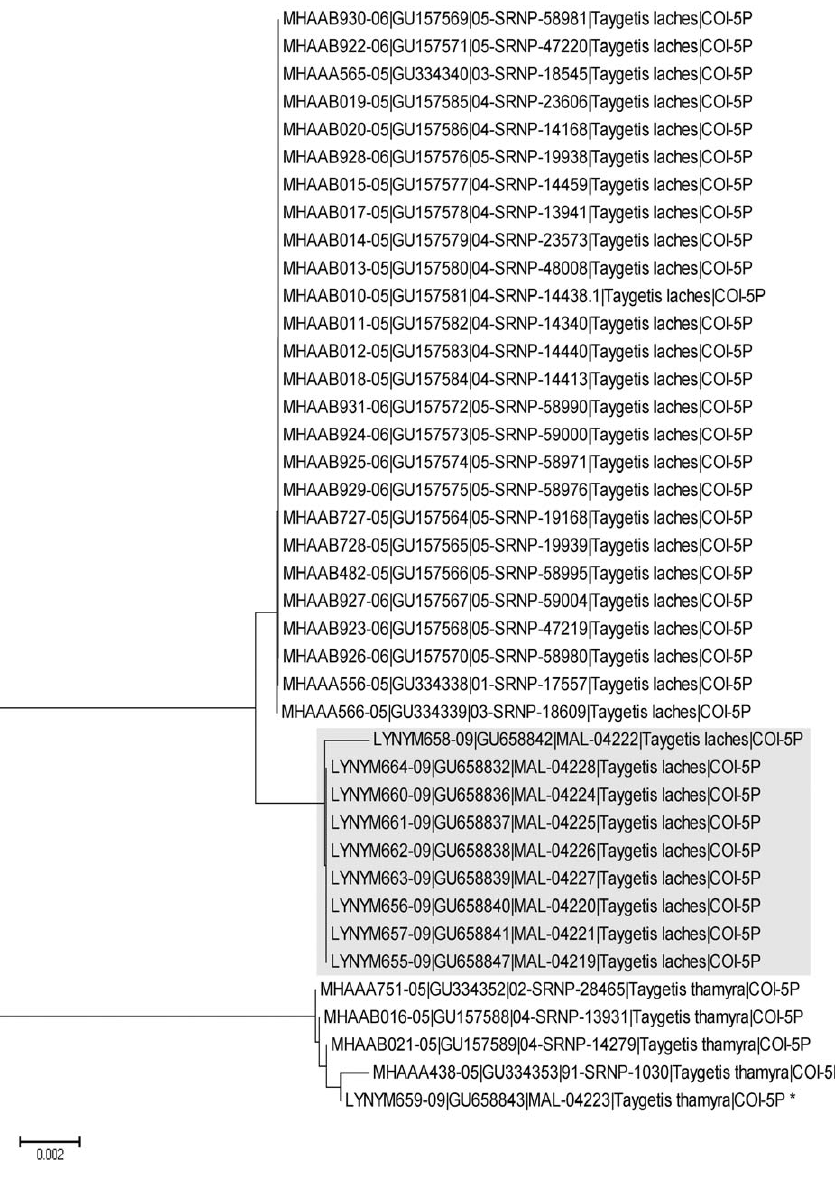
Figure 6. NJ tree showing specimens of T.laches and T.thamyra from Yucatan and Costa Rica. Specimens of T. laches (in grey) from the Yucatan group together and are differentiated from Costa Rican specimens, although they have less than 2% K2P divergence indicating they are likely geographic forms of a single species. The record marked with an asterisk derives from a specimen of T. thamyra from the Yucatan Peninsula which is grouped with Costa Rican